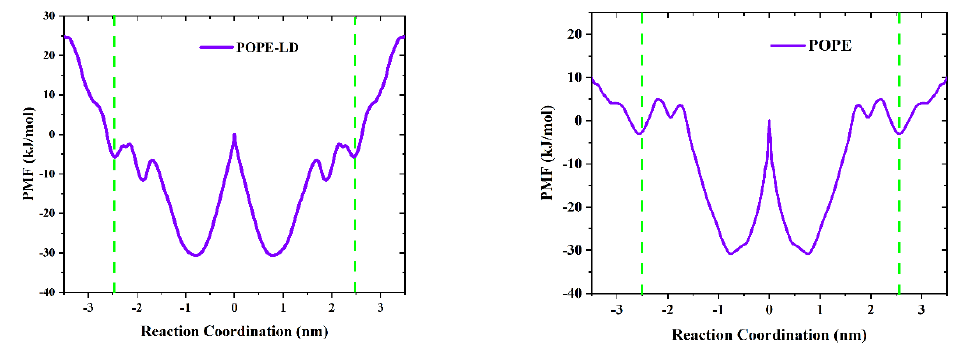
Figure 7. The average force (PMF) potential of GQD transport through the membrane. The green dotted line indicates the two boundaries of the cell membrane.